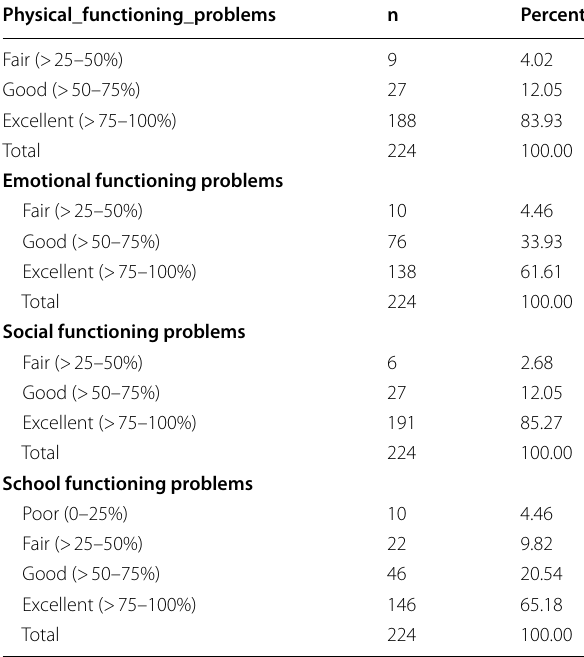
Table 5 Results of Quality of Life scoring assessment